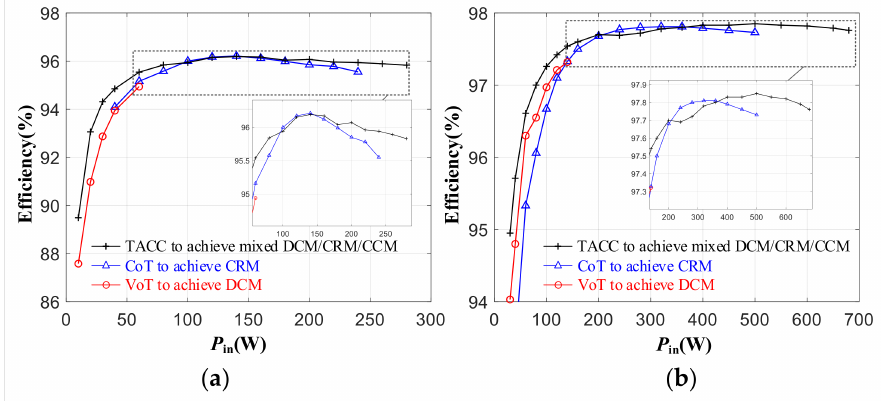
Figure 20. Measured efficiencies ( a ) with 110 VAC input; ( b ) with 220 VAC input.